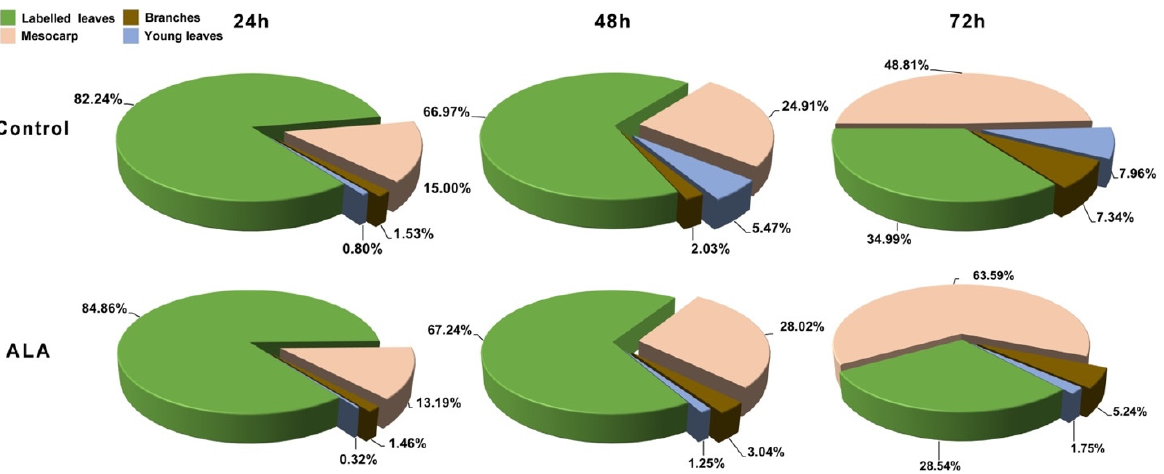
Figure 3. Distribution ratio of 14 C radioactivity in different organs after leaf labelling. The data are the means from three biological replicates.